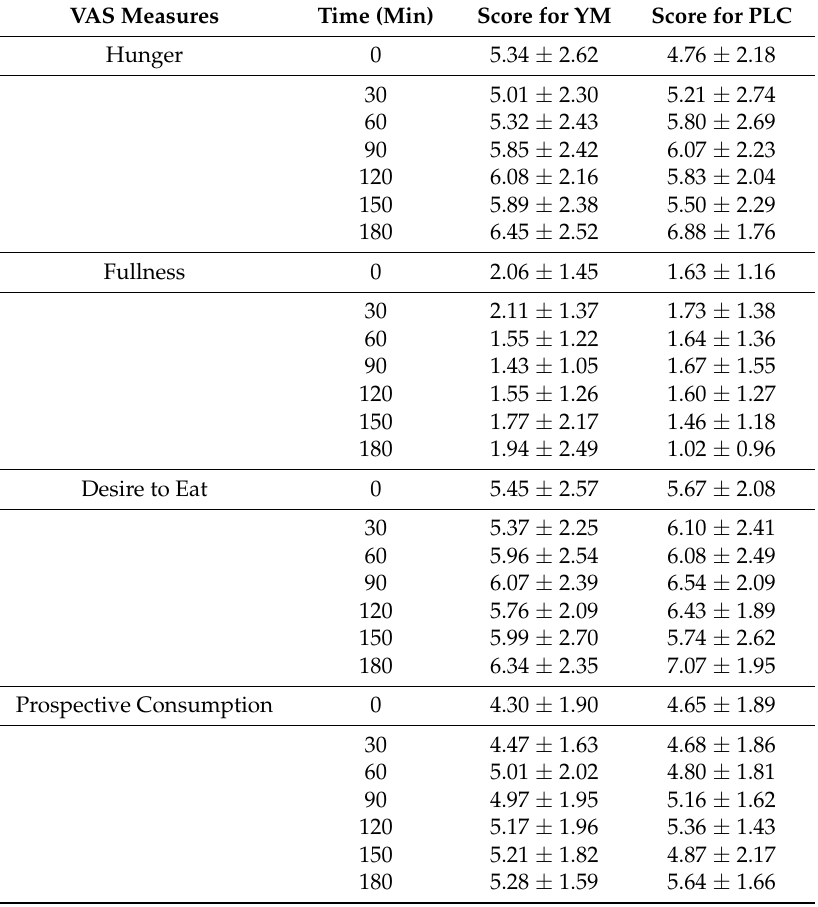
Table 1. Satiety results of Visual Analogue Scale (VAS) for Yerba Mate (YM) and placebo (PLC) treatment at different time points, at rest (0–120 min), exercise (120–150 min), and post exercise (180 min). Results displayed as Mean ±